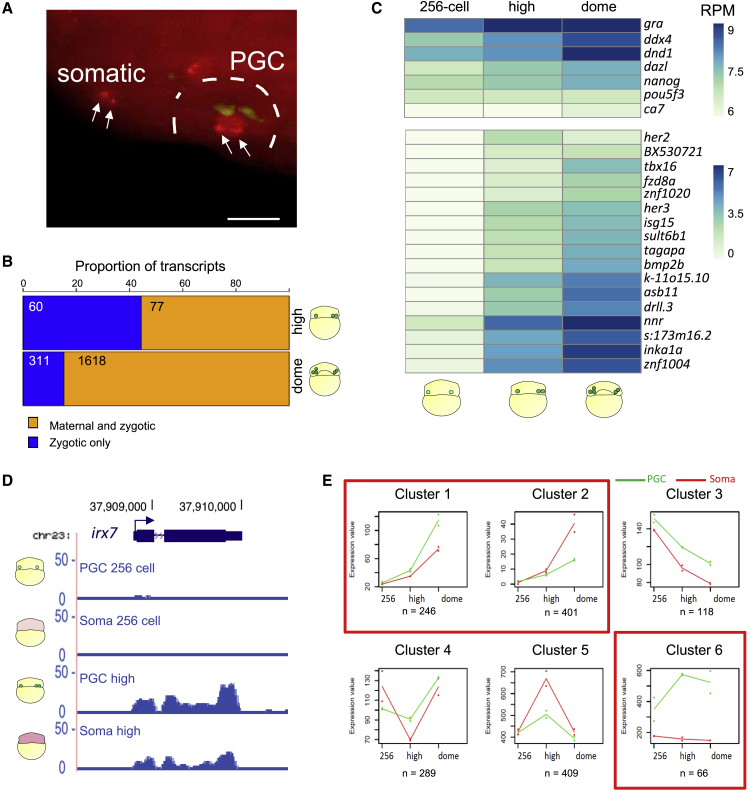
PGCs do not delay the major wave of transcriptional activation(A) Maximum intensity projection of a multi-stack image showing miR-430 transcription foci (arrows) detected by fluorescently tagged morpholinos (red) in cells marked by germ-plasm-localized GFP-Buc (green) and somatic cells at 512-cell stage. Scale bar, 30 μm. Number of embryos, n = 24.(B) Proportion of zygotic and maternal/zygotic genes upregulated in the germ-plasm-carrying cells at high and dome stages.(C) Expression heatmap of differentially regulated genes in germ-plasm-carrying cells. Scale bar represents scaled RPM. padj < 0.1.(D) Genome browser view of normalized RNA-seq reads for irx7 gene.(E) Clusters of gene expression trends among three developmental stages in PGCs and somatic cells. Median profiles of gene expression values are plotted for each in green (PGCs) and red (somatic cells) and represent the read counts normalized by the DESeq2-calculated size factor. Red squares highlight clusters supporting transcriptional activation in PGCs.